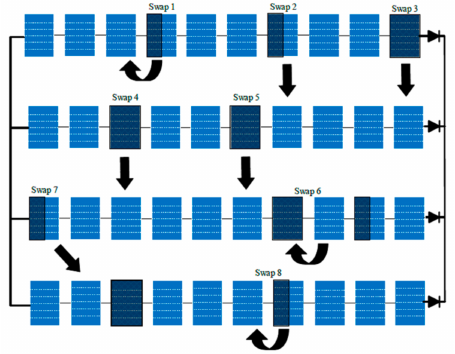
Figure 6. An example of the offline reconfiguration to swap PV modules through human labor in